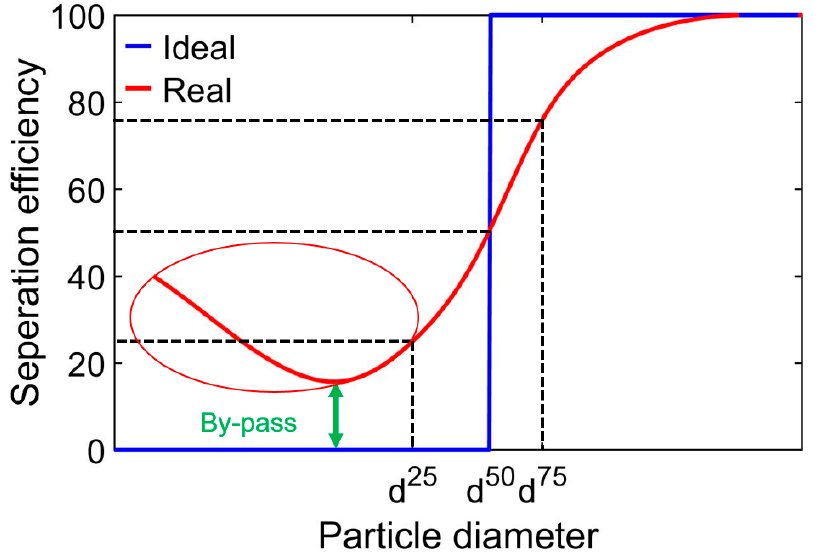
Figure 1. Cut size, fish-hook, and by-pass.